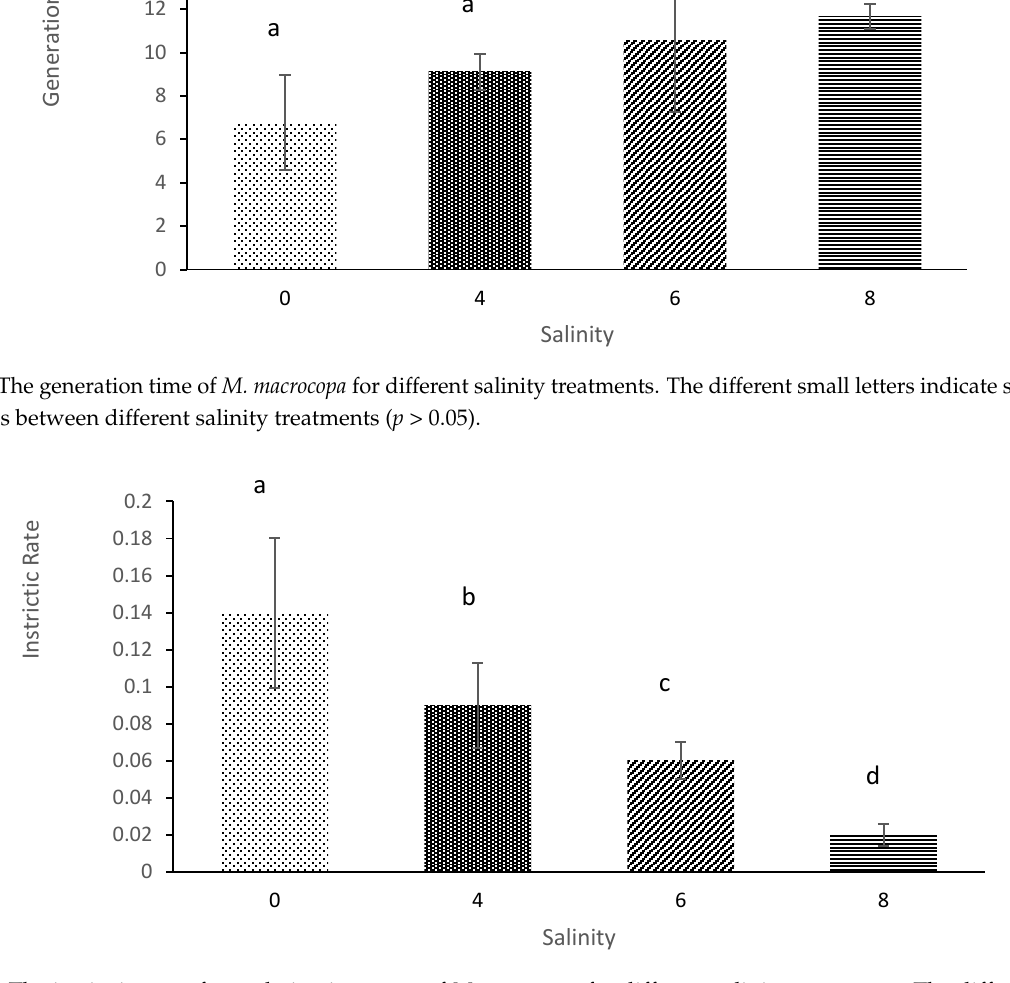
Figure 10. The intrinsic rate of population increases of M. macrocopa for different salinity treatments. The different small letters indicate significant differences between different salinity treatments ( p < 0.05).